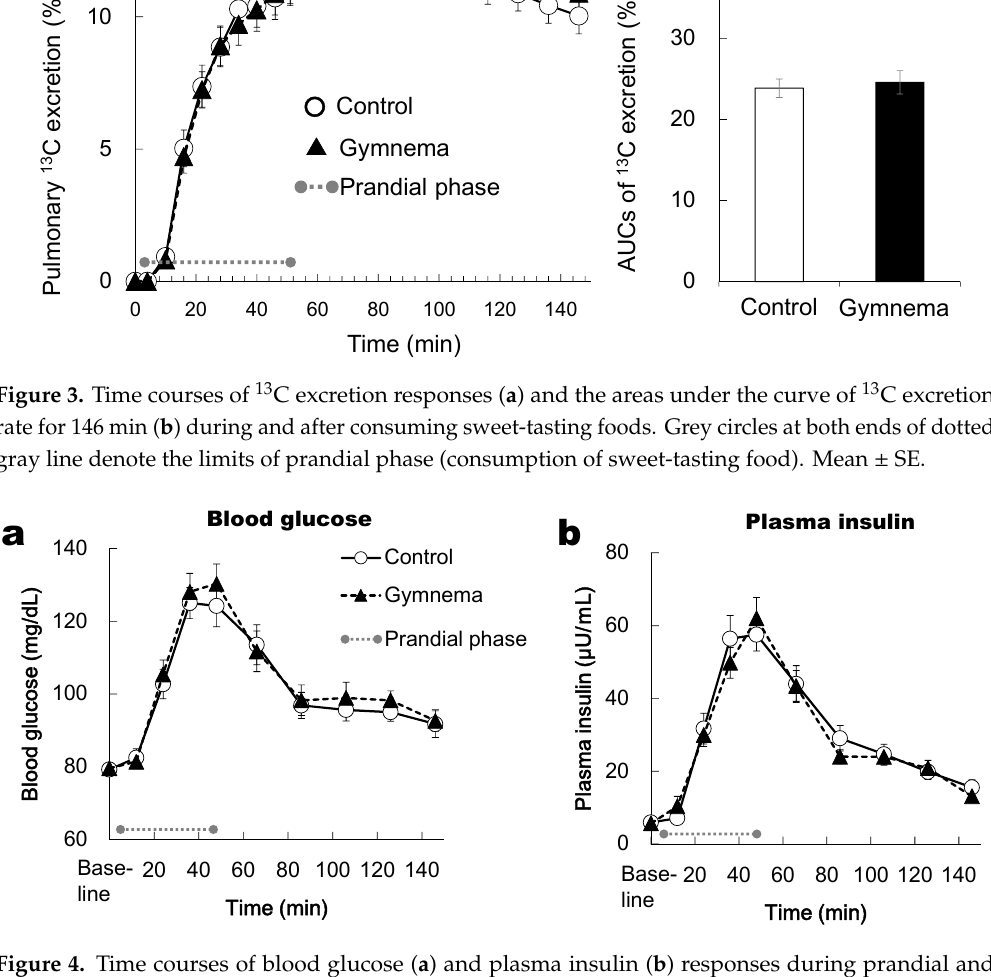
Figure 3. Time courses of 13 C excretion responses ( a ) and the areas under the curve of 13 C excretion rate for 146 min ( b ) during and after consuming sweet-tasting foods. Grey circles at both ends of dotted gray line denote the limits of prandial phase (consumption of sweet-tasting food). Mean ± SE.